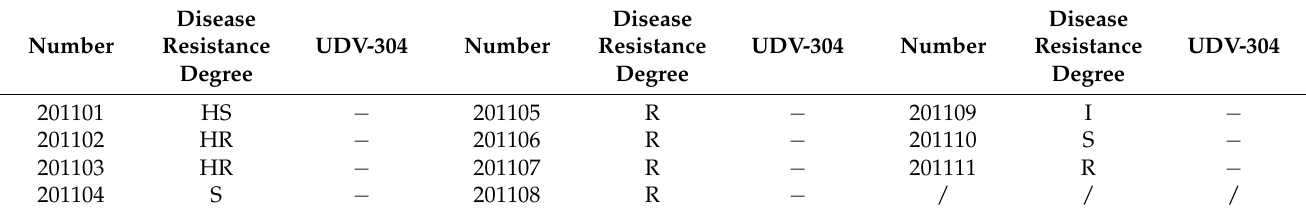
Table 9. Amplification results of UDV-304 marker in combination 6.